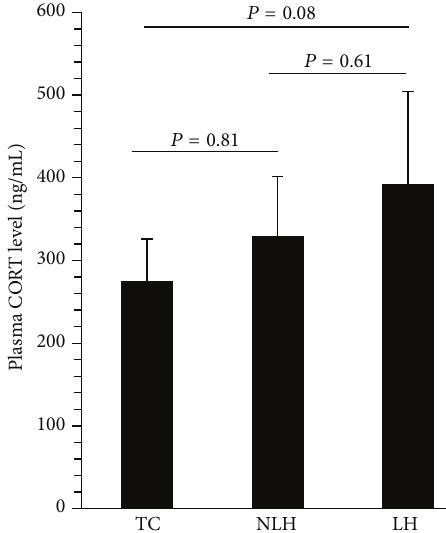
Figure 2: Plasma corticosterone (CORT) levels in TC, non-learned helpless(non-LH),andlearnedhelpless(LH)rats.Dataarethemean ± SD from 6 animals per group. The overall group differences were as follows: df = 2, 15 , 𝐹 = 3.07 , and 𝑃 = 0.29